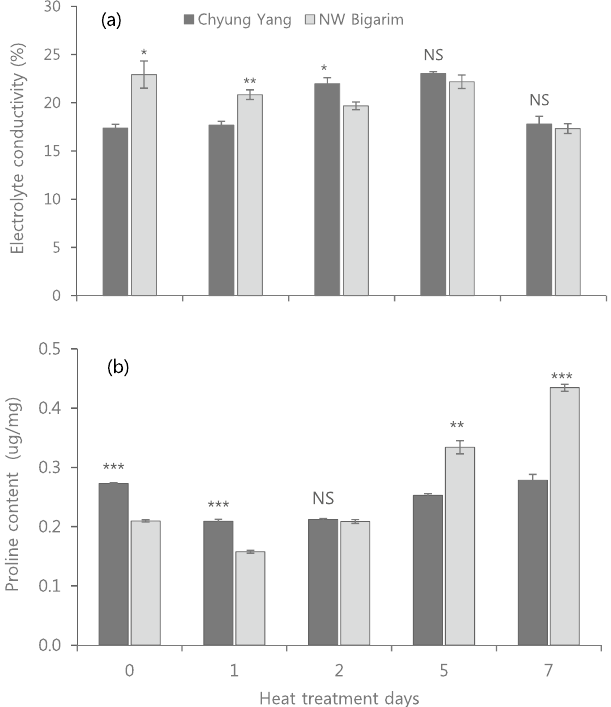
Figure 2. Electrolyte conductivity ( a ) and proline content ( b ) as affected by different heat treatment days in seedlings of two hot pepper cultivars grown in 42 °C. Vertical bars represent standard deviation (n = 3). NS, *, ** and *** indicate not significant and significant at the P < 0.05, P < 0.01 and P < 0.001 levels in t-test,